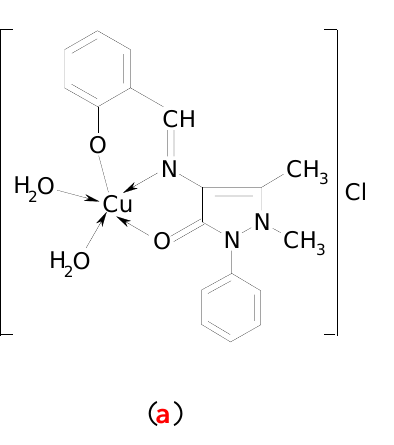
H N O )(H O) ]Cl ( a ) 18 16 3 2 2 2